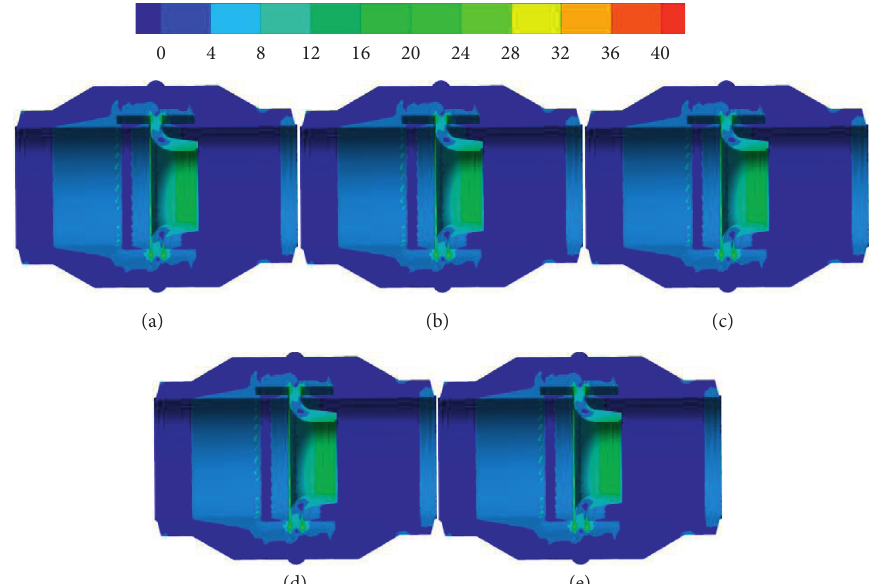
Figure 16: Dynamic stress distribution of cross section in flow meters (1000m 3 /h). (a) 50 ° C. (b) 100 ° C. (c) 300 ° C. (d) 500 ° C. (e) 700 °